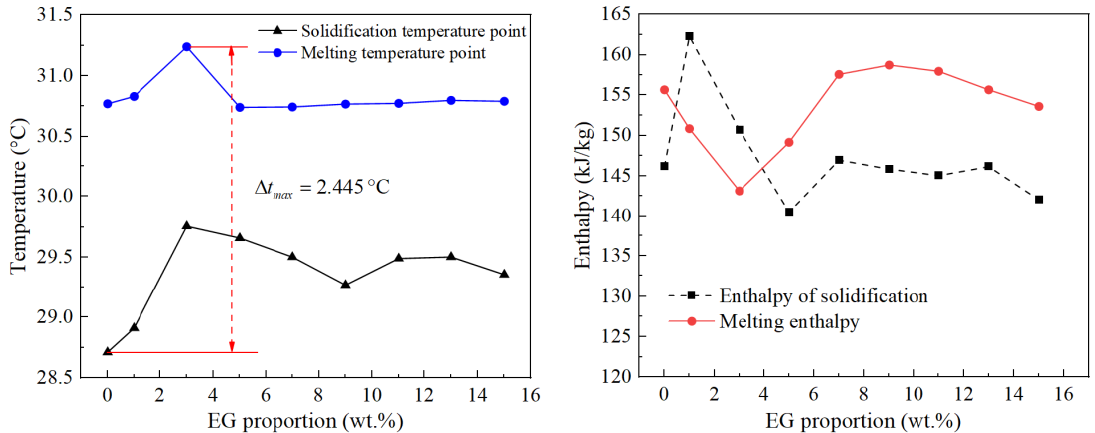
Figure 7. DSC curves of the composite PCMs: ( a ) 0 wt.% EG; ( b ) 1 wt.% EG; ( c ) 3 wt.% EG; ( d ) 5